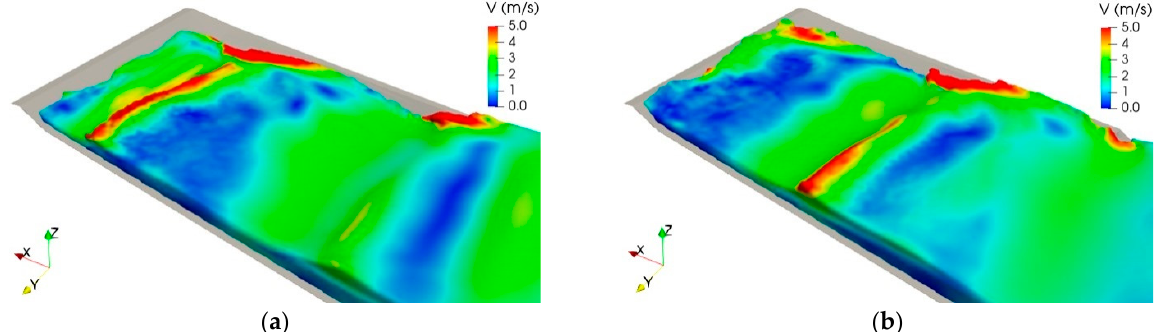
Figure 24. Free surface obtained with DualSPHysics for the moment when: ( a ) wave run-down the dike; ( b ) wave overtops the groin (free surface is coloured by velocity magnitude).